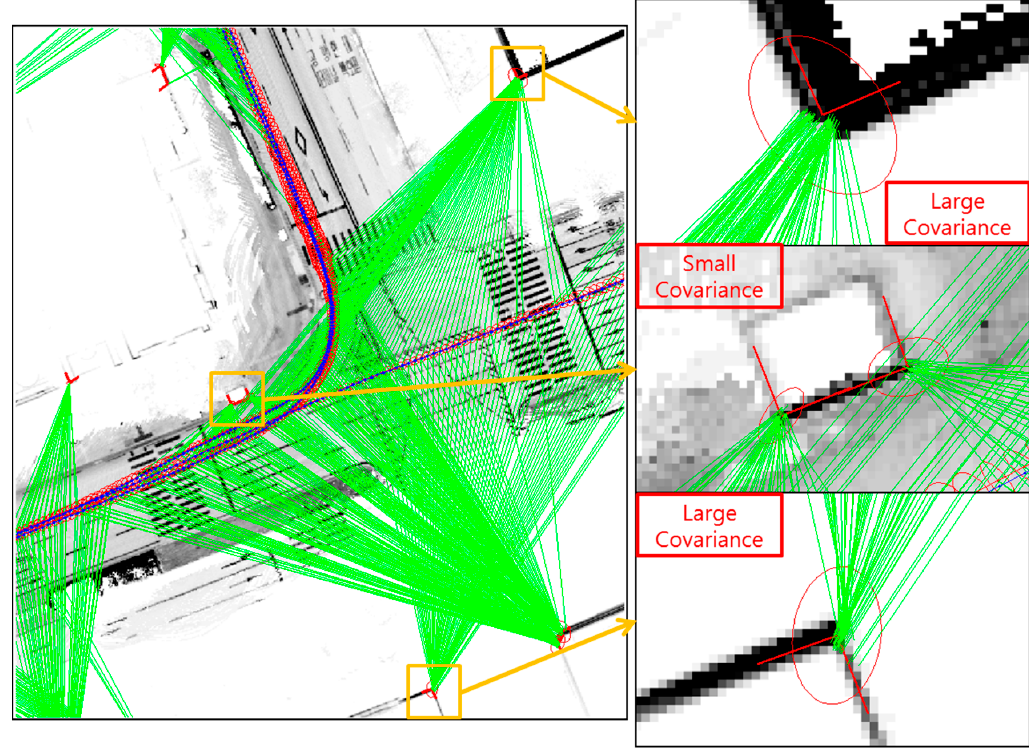
Figure 24. Relationship between the corner position error covariance and the distance from the vehicle to the corner (the red ellipses on the corner represent the position error covariance of the extracted corners).